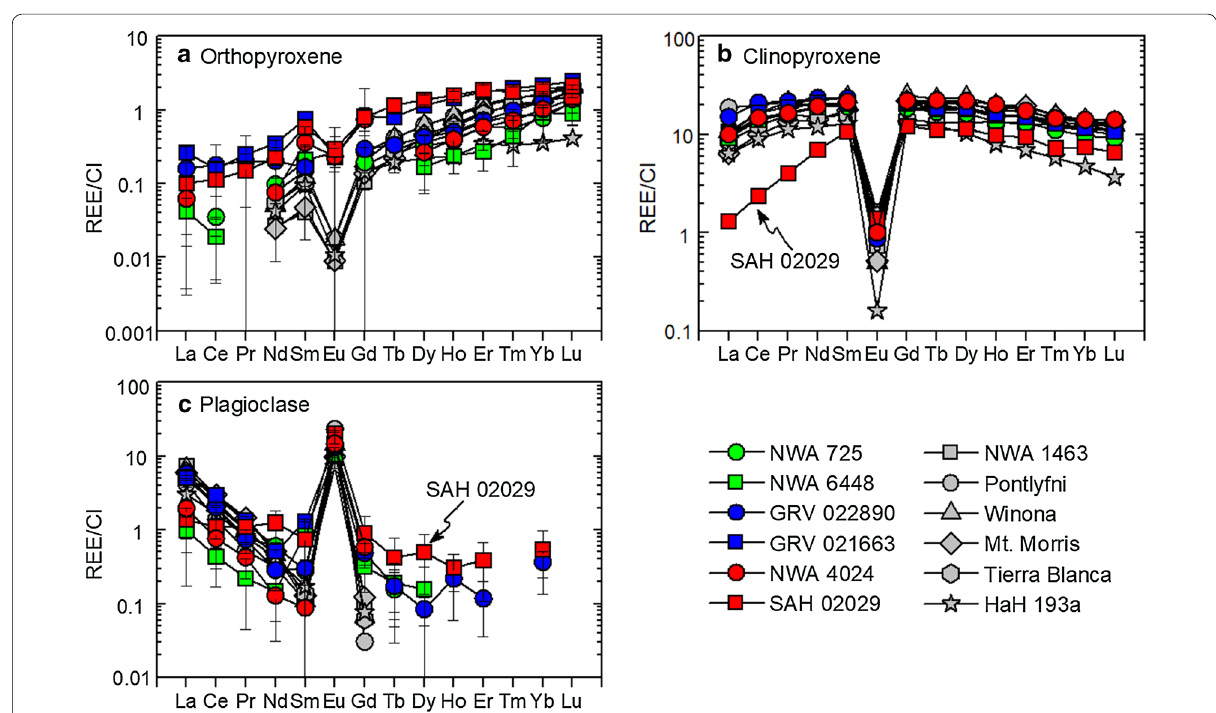
Fig. 6 Average CI chondrite-normalized (Anders and Grevesse 1989) REE patterns for orthopyroxene ( a ), clinopyroxene ( b ), and plagioclase ( c ) in winonaites. The color symbols represent the studied meteorites. The light gray symbols represent the literature data for other winonaites (Floss et al. 2008). REE composition for GRV 021663 was taken from Li et al. (2011). Error bars (1 SD) are shown for orthopyroxene and plagioclase. The error bars (1 SD) for clinopyroxene are within the size of the